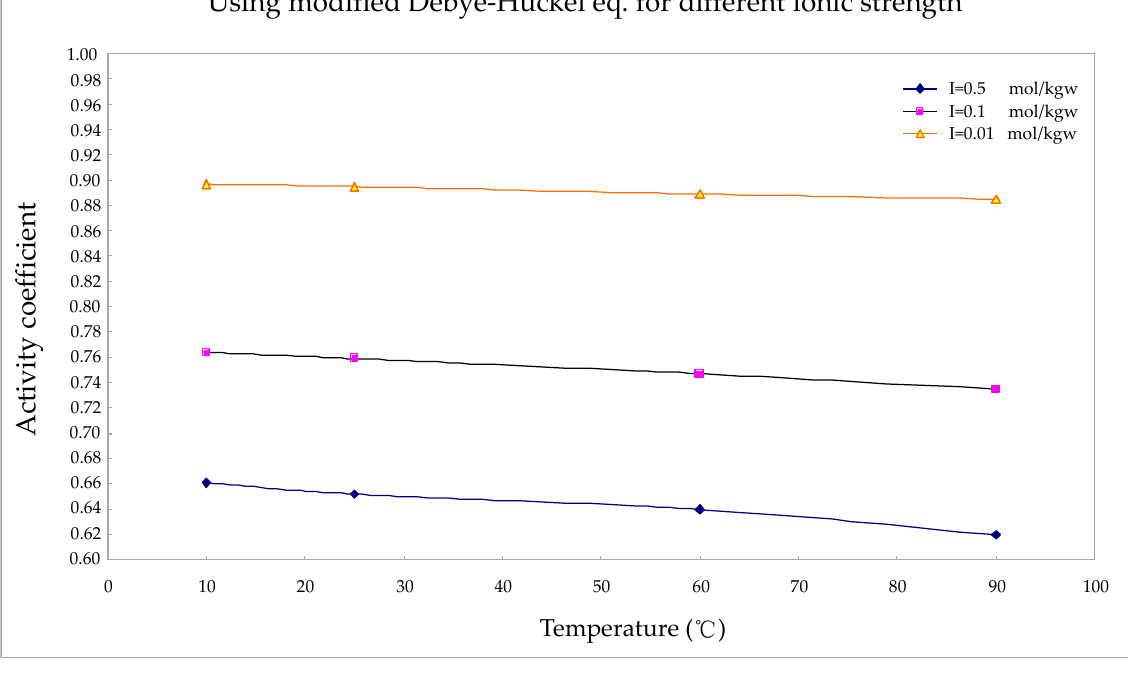
Figure 16. Dependence of the activity coefficient of Na + on the temperature calculated by the modified Debye–Hückel equation through EQ3/6.